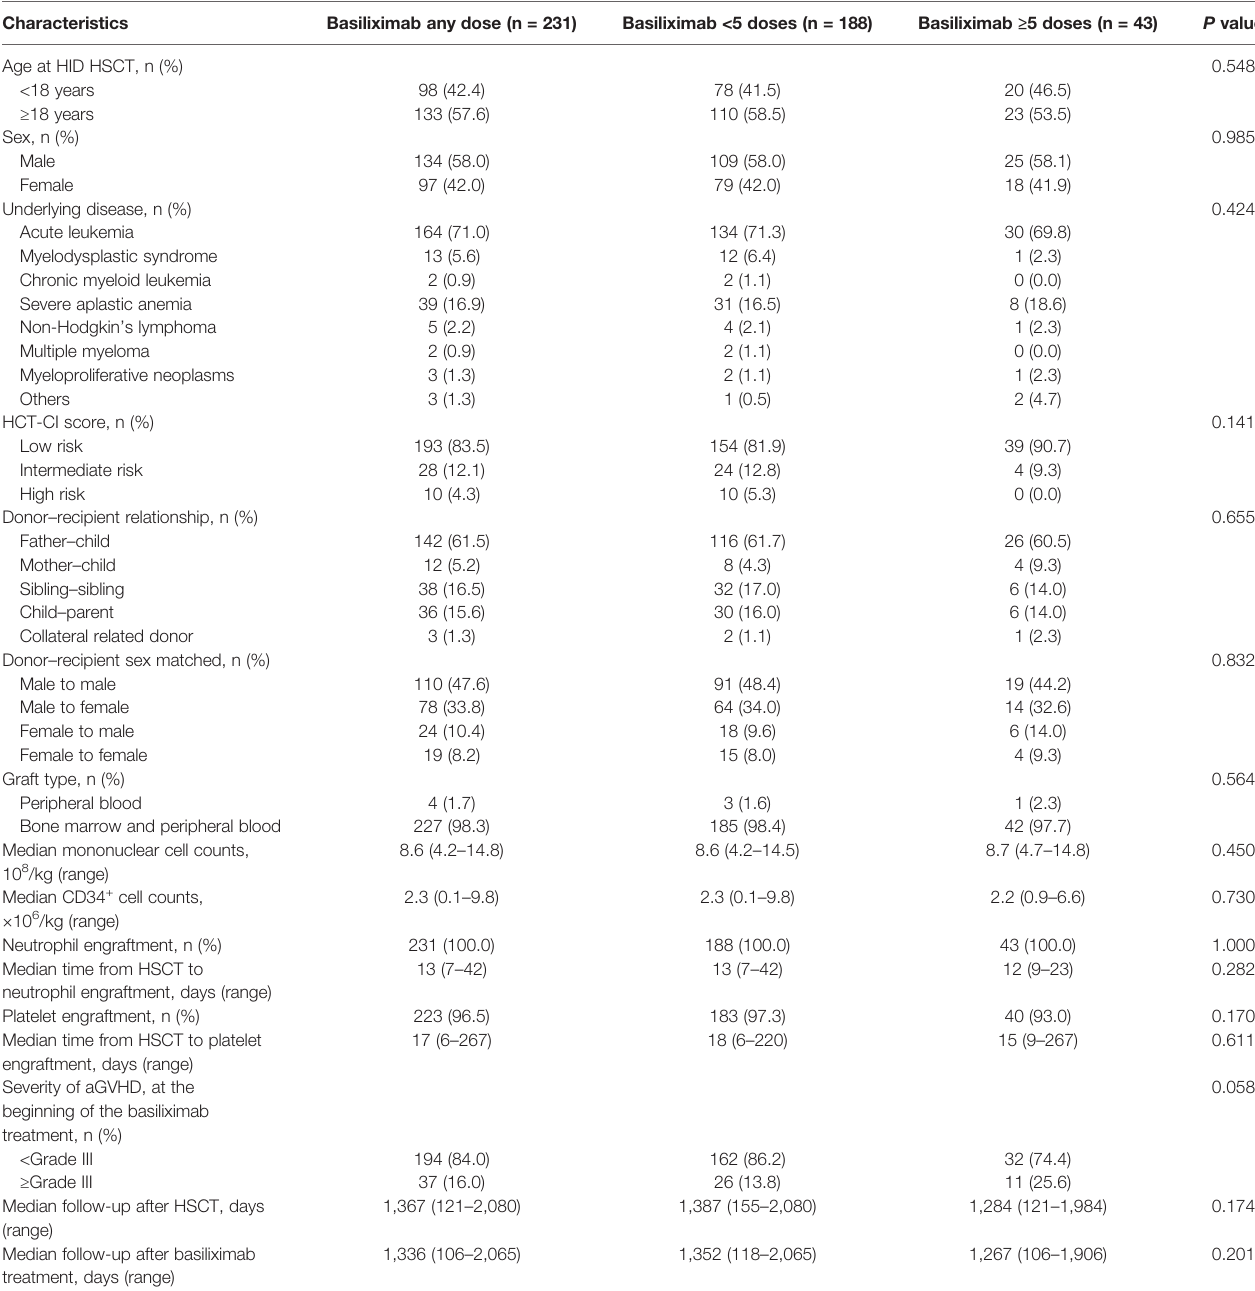
TABLE 1 | Clinical characteristics of patients included for IR analysis after HID HSCT (n =